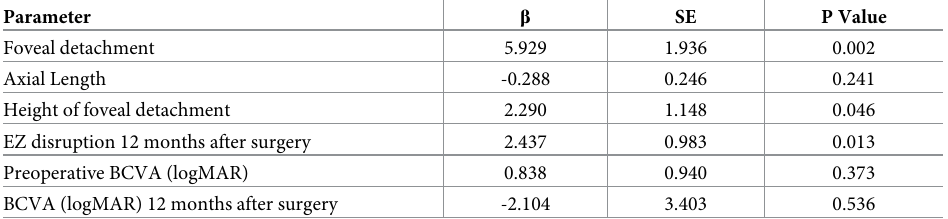
Table 2. Logistic regression analysis including the presence or absence of preoperative foveal detachment as an independent variable. Parameter